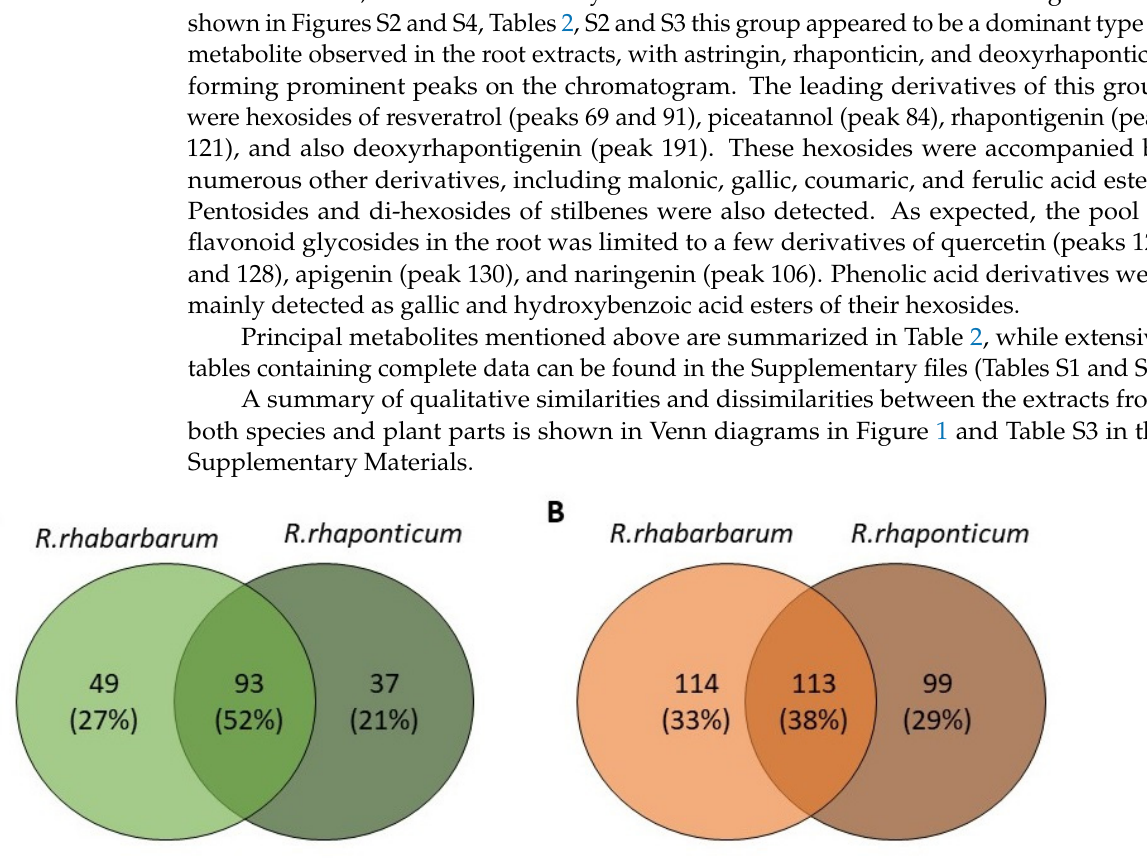
Figure 1. Qualitative similarities between the extracts from the petioles ( A ) and roots ( B ) of R. rhabarbarum and R. rhaponticum . Numbers indicate common and unique metabolites for each species.